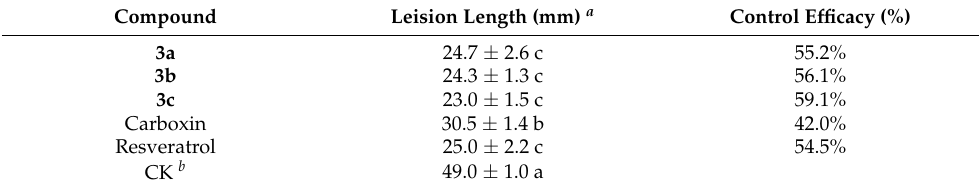
Table 2. Protective activities of compounds 3a – 3c against tomato gray mold at 400 µ g/mL under greenhouse